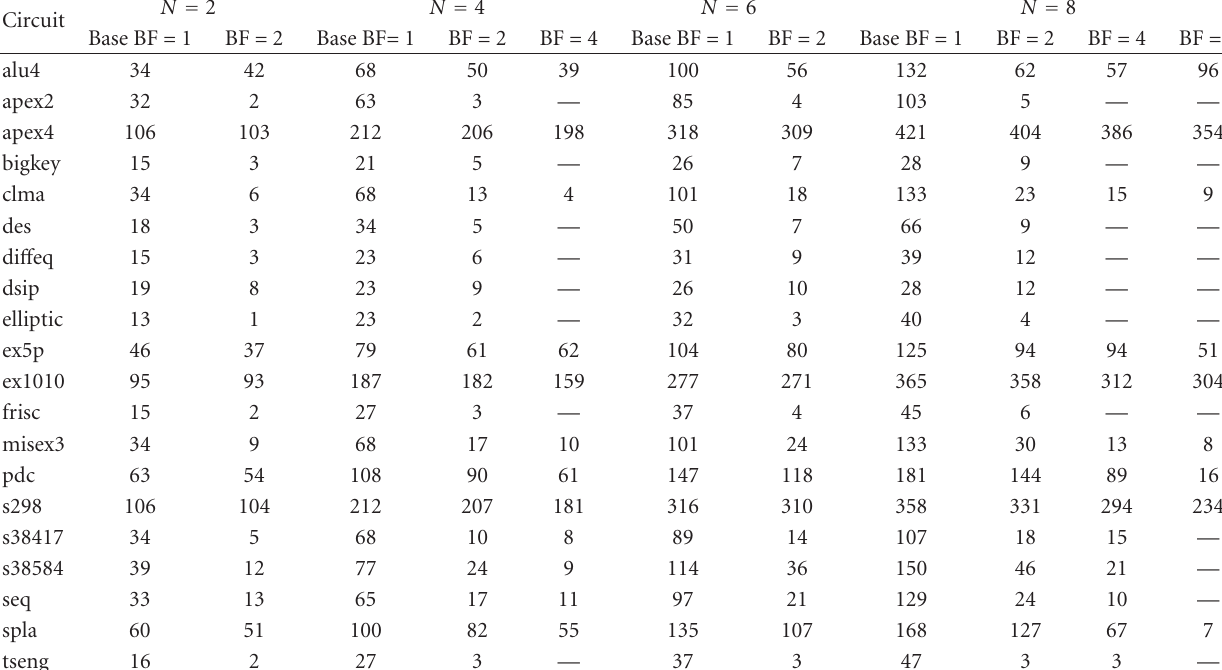
Table 3: Number of LUTs packed into memory blocks ( B =